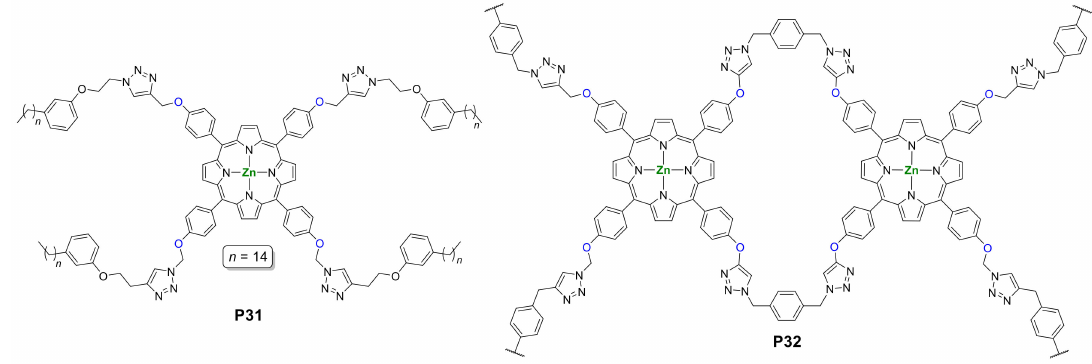
Figure 3. Structures of porphyrin-cardanol hybrid P31 and porphyrin-based polymer P32